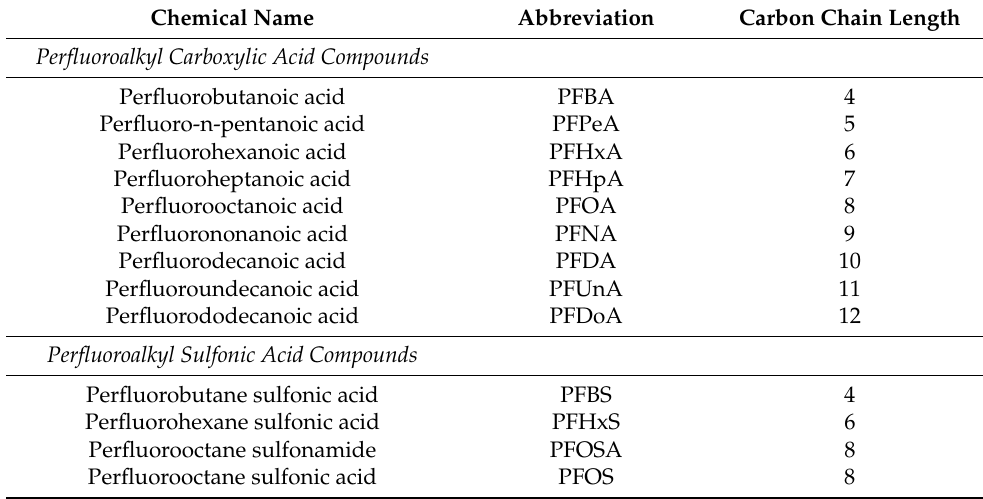
Table 1. Perfluoroalkyl substances analyzed in smallmouth bass plasma.